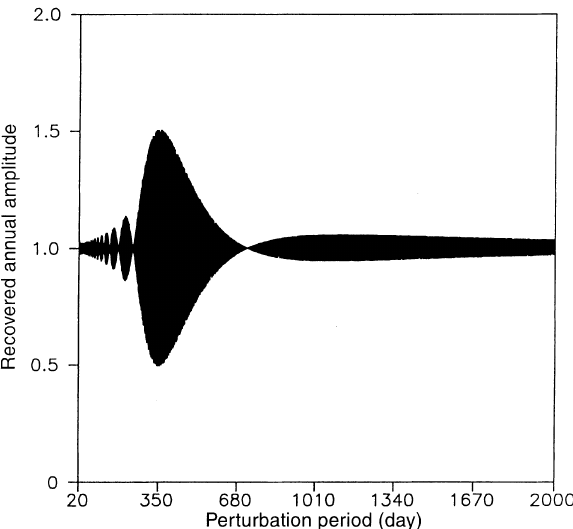
Fig. 5. Same as Fig. 2b, except that the ratio of amplitude of signal versus perturbation